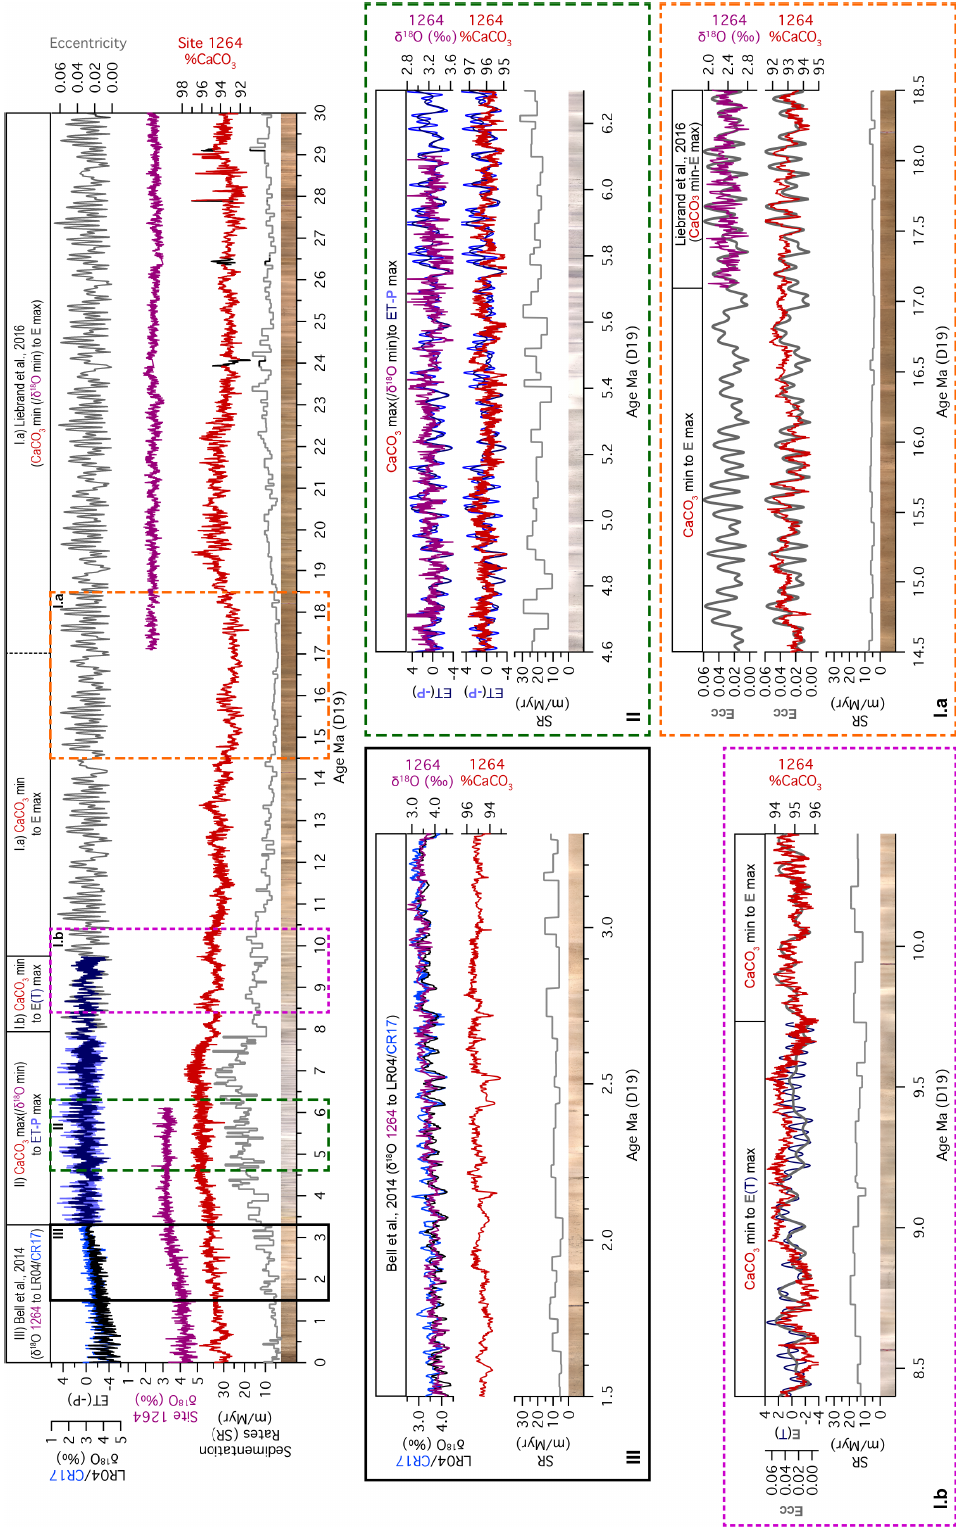
Figure 4. Overview of the new astrochronology for the last 30Myr. The four panels show the different tuning strategies employed. (I.a) 30– 9.7Ma: CaCO 3 (/benthic δ 18 O) to eccentricity; (I.b) 9.7–8.0Ma: CaCO 3 to E ( T ); (II) 8.0–3.3Ma: CaCO 3 (/benthic δ 18 O) to ET – P ; and (III) 3.3–0.0Ma: benthic δ 18 O to LR04. The composite core photo compiled from line scan images is used here as it highlights the sedimen- tological cyclicity best. Zoomed in figures showing the exact depth-age tie points are shown in Fig. S10. Clim. Past, 17, 2091–2117,